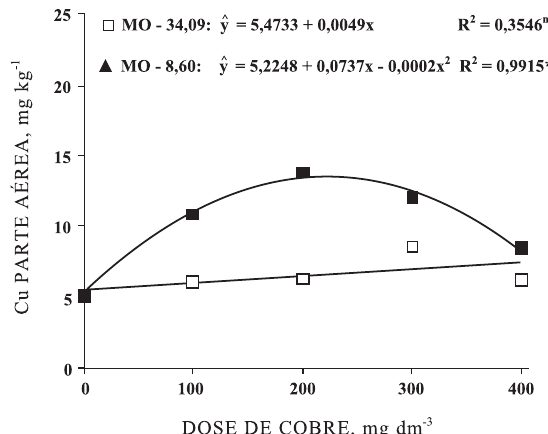
Figura 2. Teores de cobre na parte aérea da planta de milho cultivada em amostras de Latossolo Vermelho eutroférrico (duas profundidades de coleta) após receber doses de cobre e dejeto